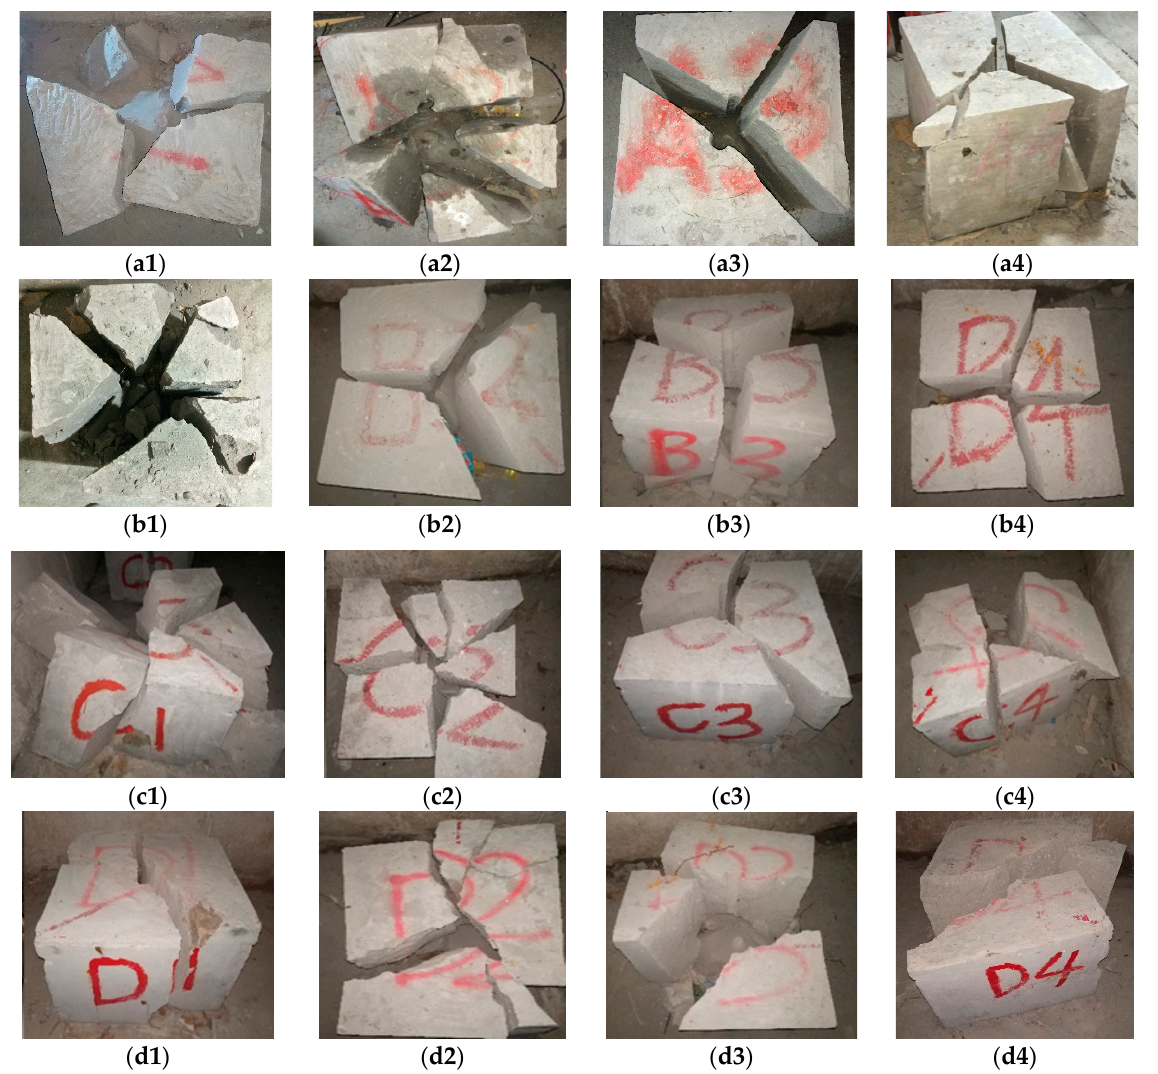
Figure 4. Blasting results. ( a1 )–( a4 ) Blasting results of specimens A-1 to A-4; ( b1 )–( b4 ) Blasting re-